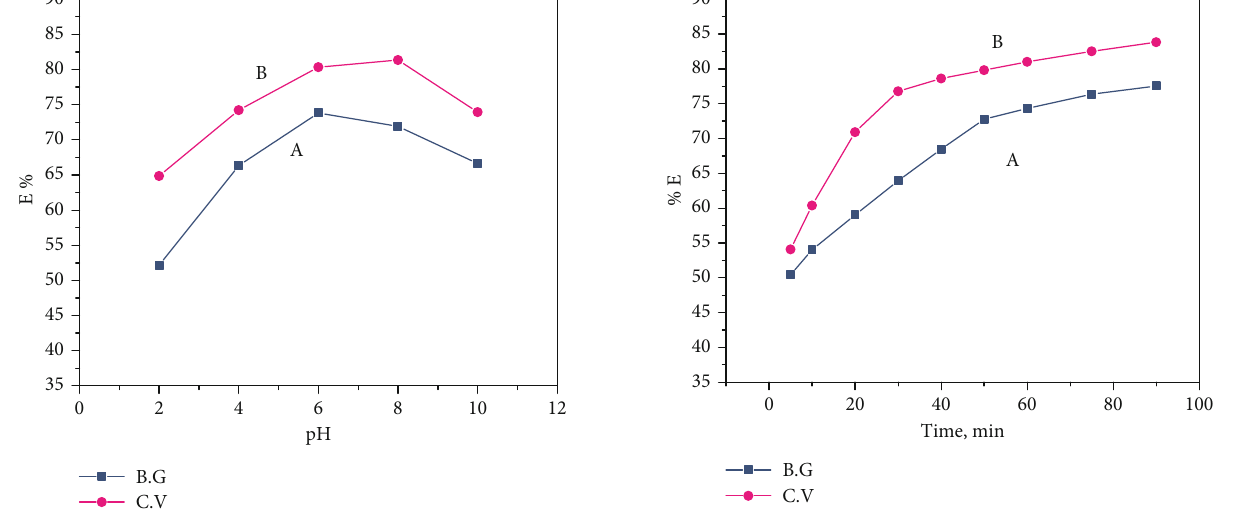
C.V. 1 : 73 ± 0 : 05 min [3], in accordance with t